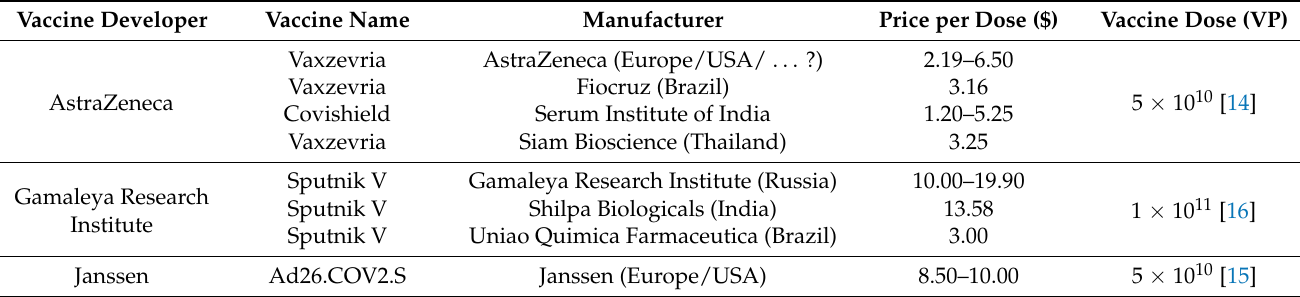
Table 10. Selling price per dose of adenoviral vector vaccines against COVID-19. Vaccine names, manufacturers and prices were obtained from UNICEF